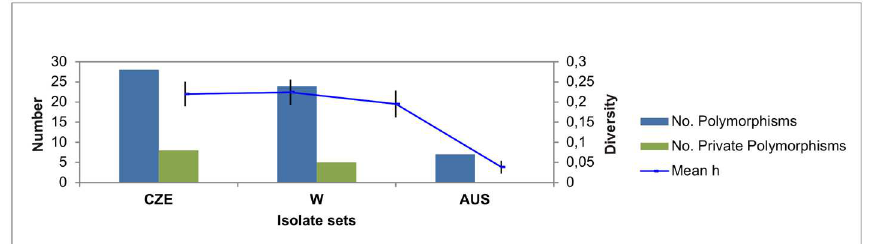
Fig 1. Polymorphism patterns across sets of Bgh isolates inferred from genotyping by SSR, RJM, indel and SNP markers. The number of polymorphisms observedin the populationof isolates collectedin the Czech Republicin season 2012 (CZE), collectionof isolates from aroundthe world (W) and populationof isolates collectedaroundAustralia in season 2011 (AUS) is represented by the blue column.The green column illustrates amount of private polymorphisms. The mean diversity (Mean h) amongthe sets of isolates is marked by blue line and vertical bars represent standard